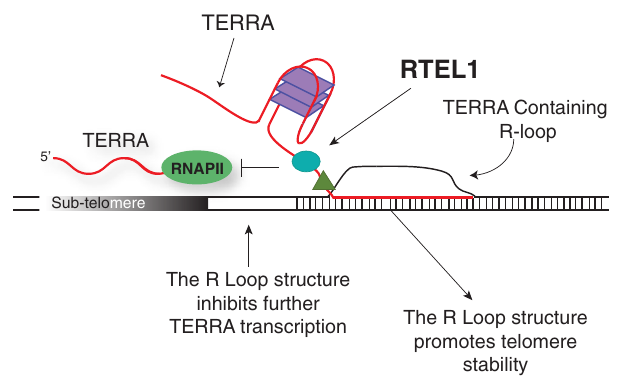
Fig. 6 RTEL1 In fl uences the Abundance and Localization of the Telomeric RNA TERRA. The formation and maintenance of the TERRA R-loop at the telomere in fl uences TERRA transcription and promotes telomere stability. We propose RTEL1 would be involved in either facilitating the creation or contributing to the maintenance of the TERRA-containing telomeric R-loop. Once established, the TERRA R-loop would limit further transcription from R-loop containing chromosome Fig. 9C, D), strengthening the idea that the R-loop exerts an in fl uence on TERRA abundance, at least from those telomeric loci.